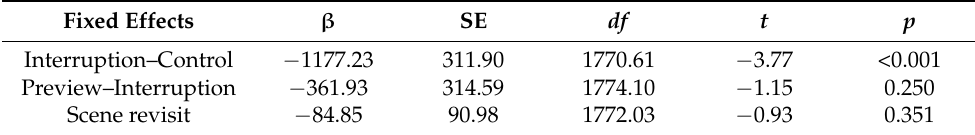
Table A1. Preregistered main analysis of response time